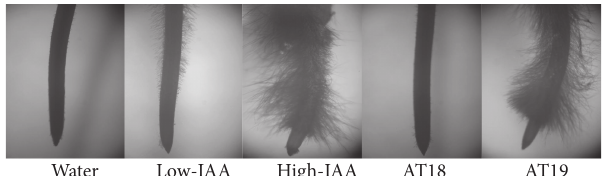
Figure 4: Effect of IAA pure solutions and cell-free cultures of A. salinestris treatments on root morphology of 4-day-old wheat seedlings. Root tips of wheat seedlings treated with solutions of 2 𝜇 g mL −1 and 20 𝜇 g mL −1 of IAA (low-IAA and high-IAA, resp.) and cell-free cultures of low- (AT18) and high- (AT19) auxin- producing Azotobacter